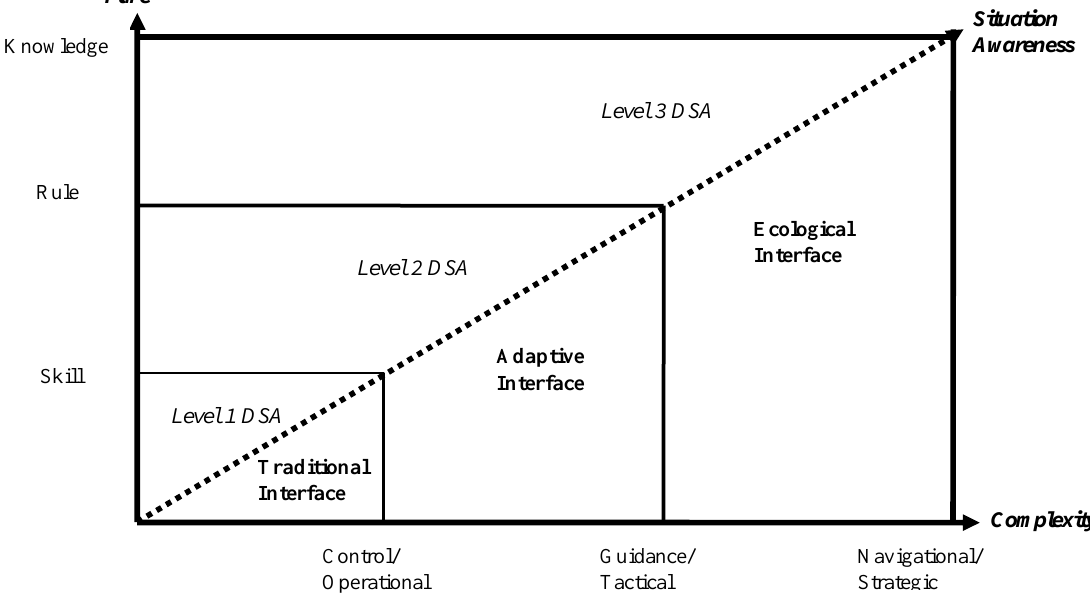
Fig. 3. Correlation of driving task and driving cognitive